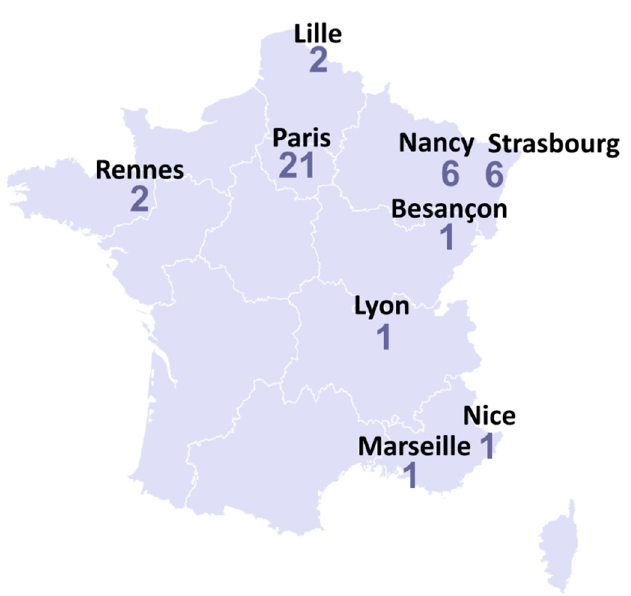
Figure 1. Reported COVID-19 cases in French pediatric oncology and hematology wards up to the 28th of May. Table 1. Main characteristics of enrolled patients.